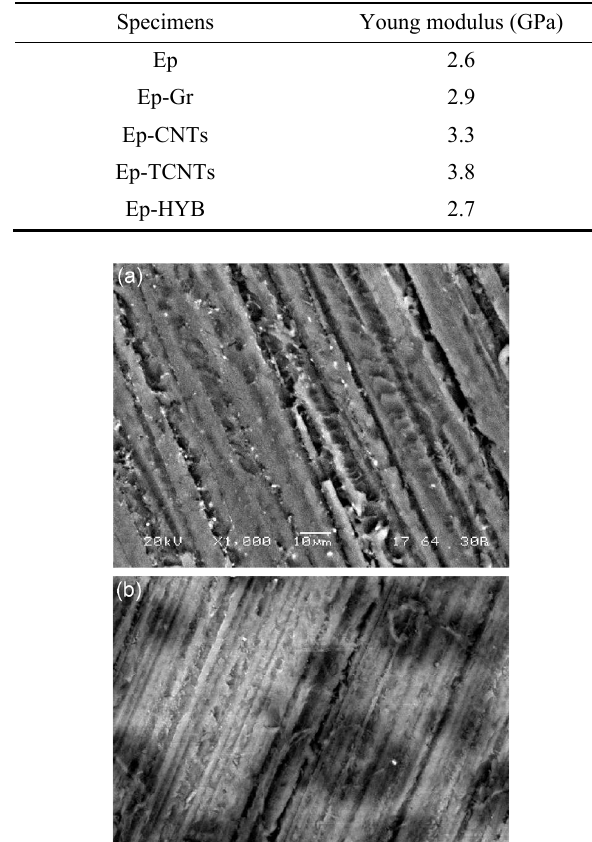
Fig. 8 Transfer film adherent to the steel ball: (a) Ep and (b) Ep-Gr. Table 2 Young’s modulus of the different tested specimens .